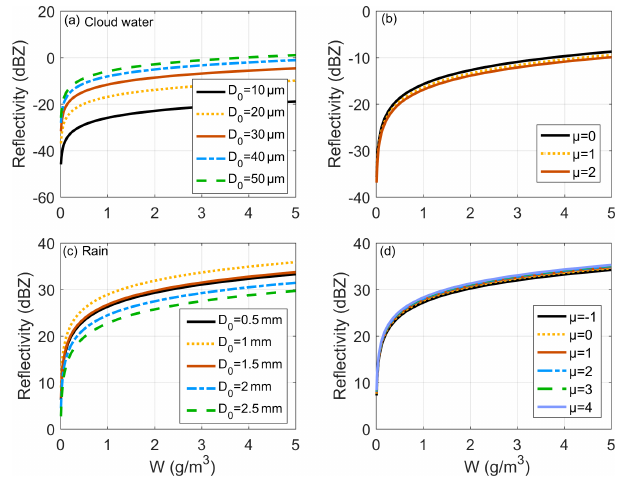
Figure 2. Impact of the PSD parameters, i.e., D 0 and µ , on radar reflectivity for cloud water and rain. Reflectivity variation in cloud water caused by (a) a D 0 of 10, 20, 30, 40, and 50µm with a µ of 1 and (b) µ values of 0, 1, and 2 with a D 0 of 20µm. Reflectivity variation in rain caused by (c) a D 0 of 0.5, 1, 1.5, 2, and 2.5mm with a µ of 3 and (d) µ values of − 1, 0, 1, 2, 3, and 4 with a D 0 of